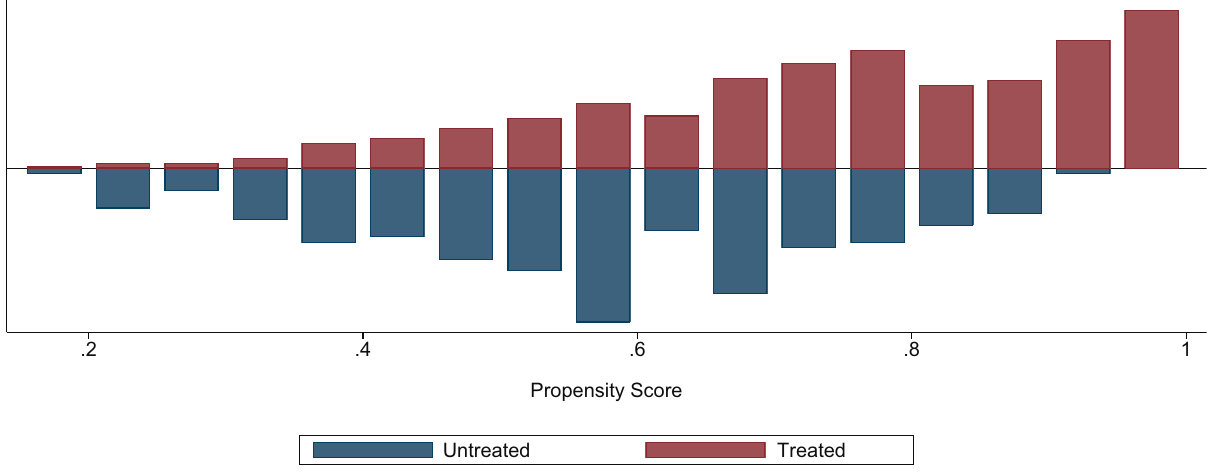
Figure 3: Propensity score distribution on the region of common support. Note: the upper and bottom halves of the graph show the distribution of propensity scores for the adopters and nonadopters of improved rice varieties, respectively. Source: Authors ’ computation.